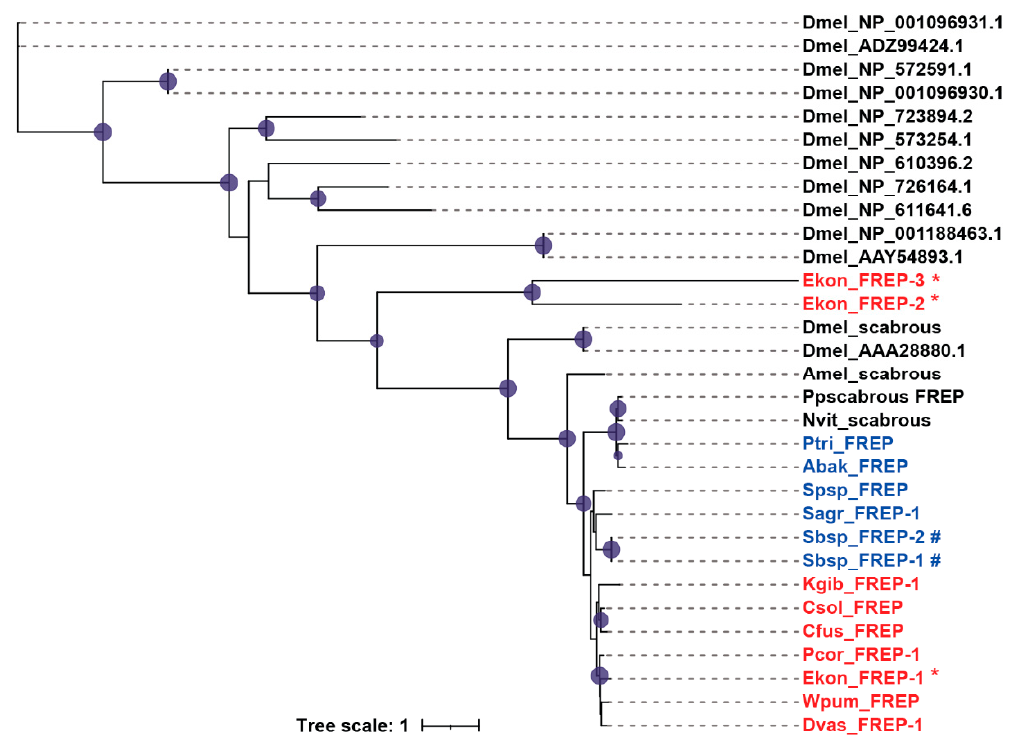
Figure 5. Phylogenetic analysis of FREPs. The amino acid sequences of FREPs of 12 fig wasp species (Table S1), D. melanogaster (Dmel), A. mellifera (Amel), N. vitripennis (Nvit), and P. puparum (Pp) were used to construct the maximum likelihood tree, and the optimal model was JTT+I+G4. The pollinators were presented in red, and the non-pollinators were presented in blue. The expanded genes in E. koningsbergeri were marked with *, and the expanded genes in Sycobia sp.2 were marked with #.